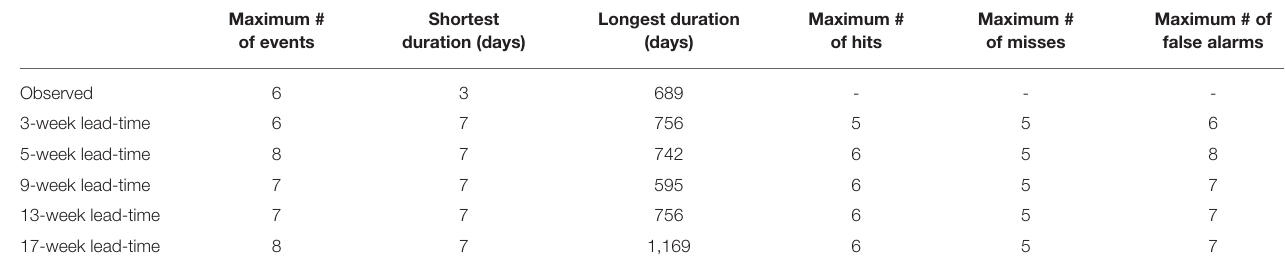
TABLE 2 | The maximum numbers of observed and predicted bleaching events, their shortest and longest event durations, and the maximum counts of hits, misses, and false alarms of the Outlook, among all grid cells, for lead-times of 3, 5, 9, 13, and 17-weeks, during the comparison time period of August 1, 2011–December 27,